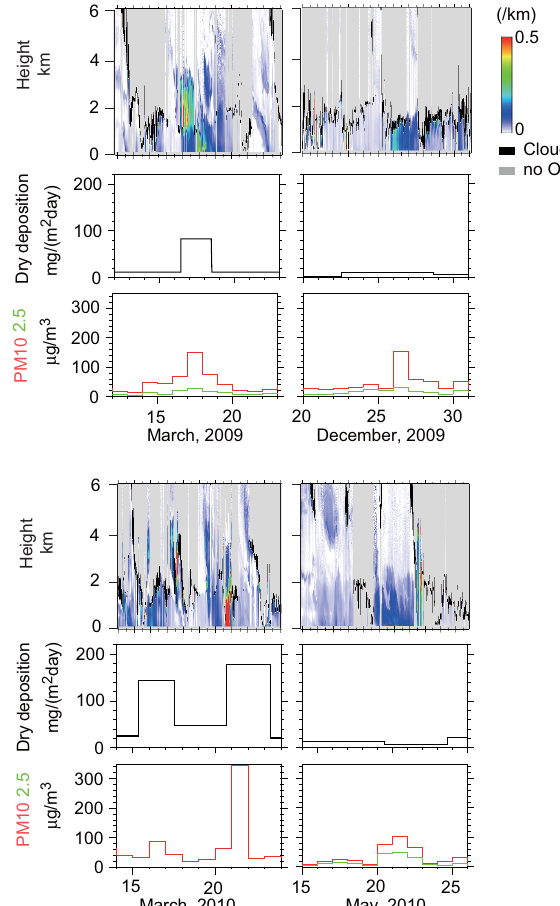
Fig. 7. Comparison of high PM 10 events with high (left) and low (right) dry deposition events in 2009 (upper part) and 2010 (lower part). Upper panels of the year show time-height sections of ex- tinction coefficient of dust particles based on lidar measurements at Matsue (NIES web site: http://www-lidar.nies.go.jp/index.html.en). Black and gray shading respectively represent clouds and height ranges of no data. Horizontal black lines in middle panels represent dry deposition flux of dusts at Tottori. Red and green horizontal lines in lower panels show PM 10 and PM 2 . 5 concentrations at Oki Island